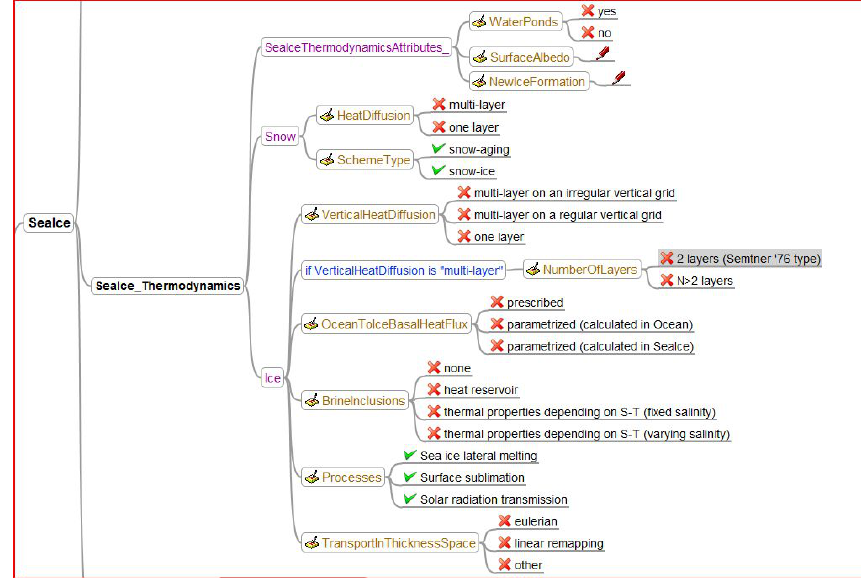
Fig. 2. A portion of the sea ice CV, showing the SeaIceThermodynamics sub-component. Black bold font denotes model components; purple is for parameter groups; blue is for conditional parameter groups; brown is for leaf parameters expecting values; black is for possible values for the leaf parameters; red cross icons mark single choice (XOR), green tick mark icons symbolize multiple choice (OR); pencil icons are for free text entry (numeric entries are also possible (not shown)); notebook icons ahead of a leaf parameter indicate that a definition is attached as a